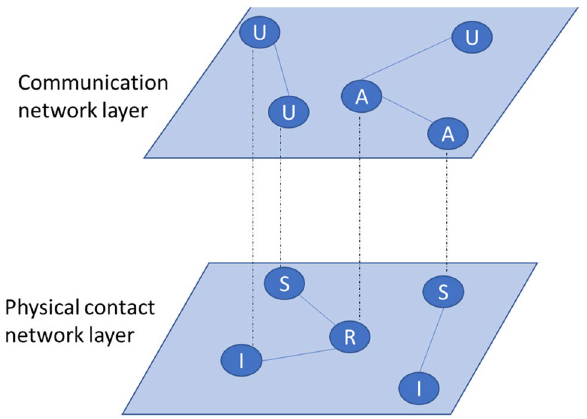
Fig. 2 Framework of two-layer multiplex networks. Upper layer indicates communication among the individuals and lower layer indicates physical contact. The dotted line indicates the relation- ship between the two layers where an aware/unaware individual could be susceptible, infected, or recovered